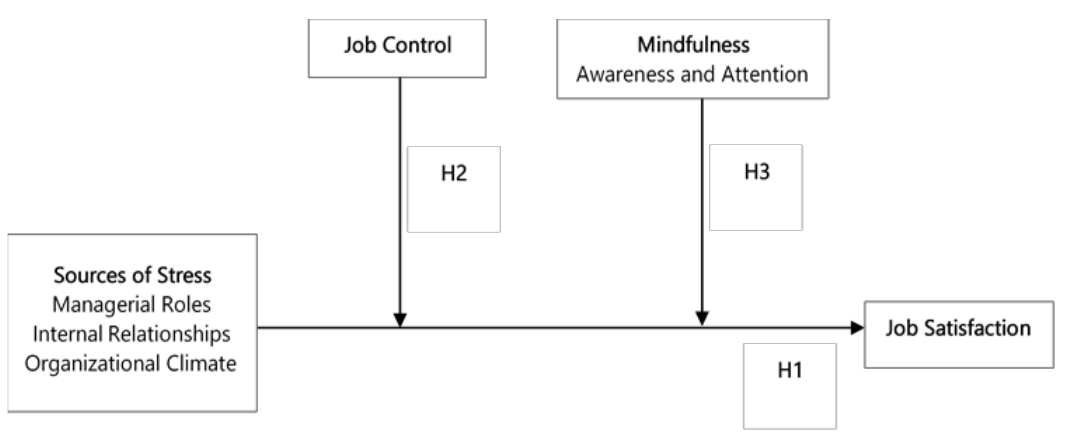
Figure 1. Tested conceptual model: job control and mindfulness as independent moderators of the relationship between sources of stress and job satisfaction. H, hypothesis.